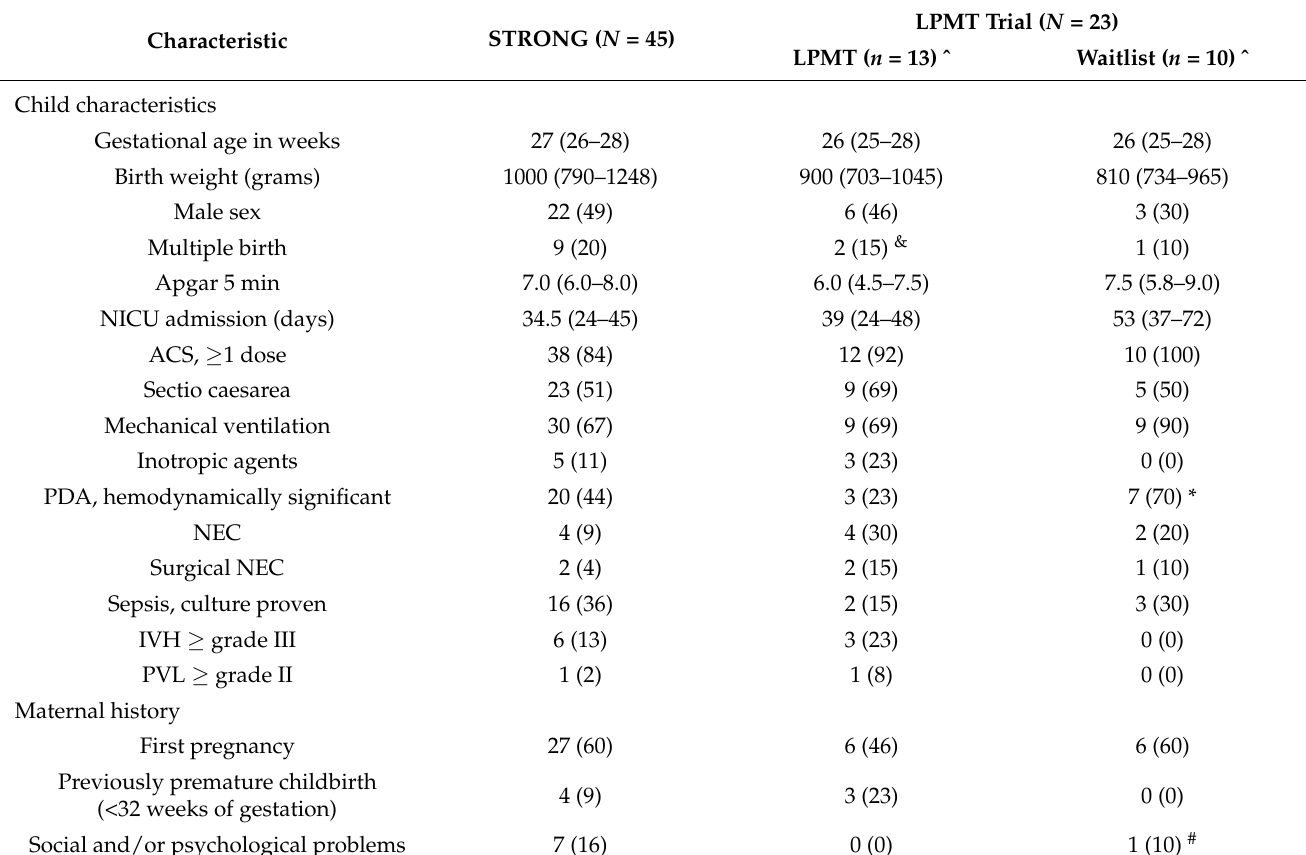
Table 1. Characteristics of participants in the STRONG study and LPMT